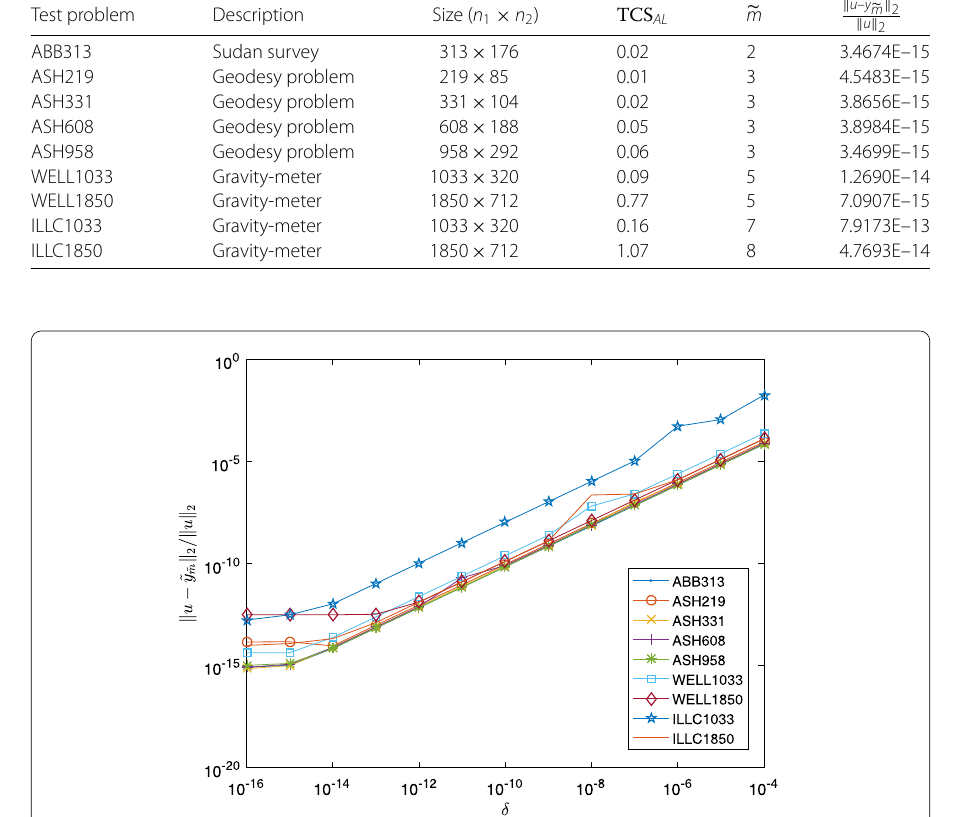
Figure 1 Relative L 2 norm of errors for the test problems in Example 2 with respect to